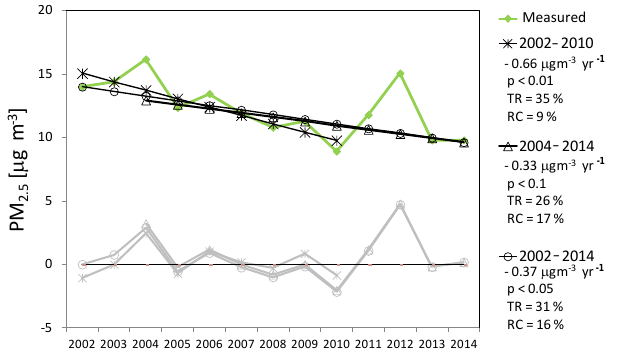
Figure 2. Mann–Kendall fit of PM 2 . 5 trends at MSY station for the periods 2002–2010 (as in Cusack et al., 2012), 2004– 2014 (this work), and 2002–2014 (largest period available in the time of writing). The magnitude of the trends (µgm − 3 yr − 1 ), p value, total reduction (TR), and residual component (RC) are reported. Significance of the trends following the Mann–Kendall test: ∗∗∗ ( p value<0.001), ∗∗ ( p value<0.01), ∗ ( p value<0.05), + ( p